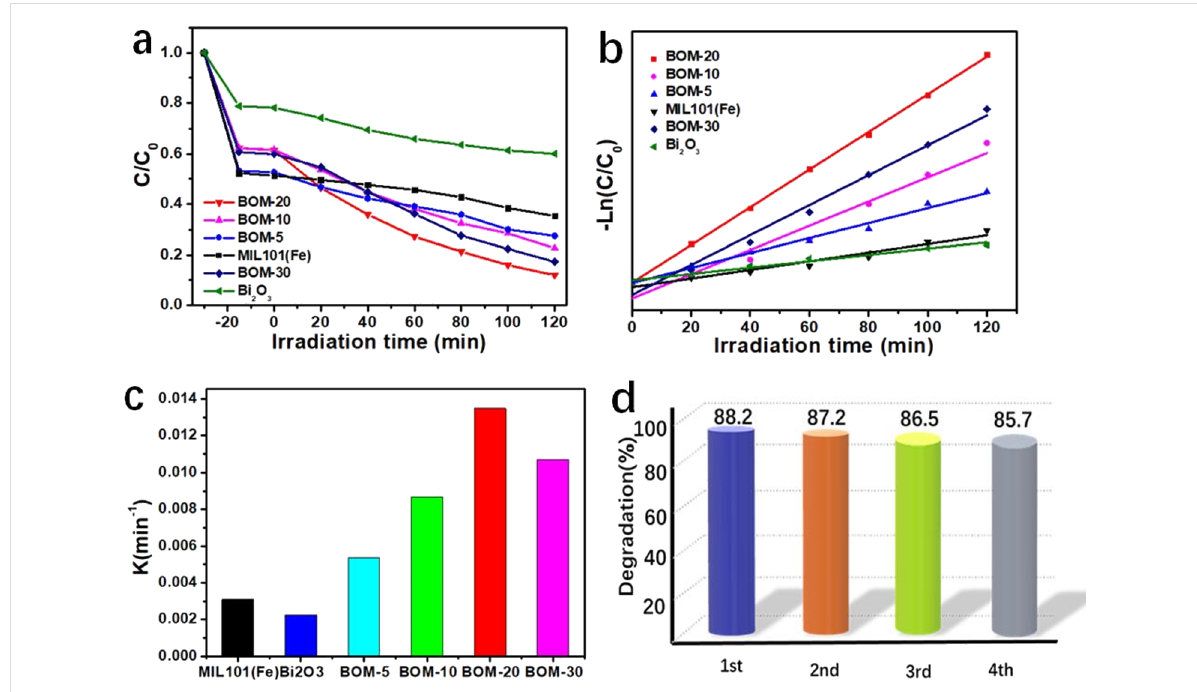
Figure 6: (a) Photodegradation of CTC over as-prepared photocatalysts under visible irradiation ( λ > 420 nm). (b) Quasi-first-order kinetic curve. (c) Apparent rate constants ( k ) and (d) degradation rate of CTC in a four-cycle test of the BOM-20 photocatalyst.